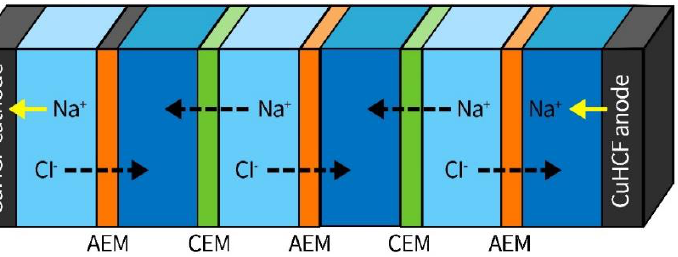
Figure 4. An MCDI cell with battery electrodes and five ion-exchange membrane stacks. Reproduced with permission from [86]. Copyright 2017 American Chemical Society.